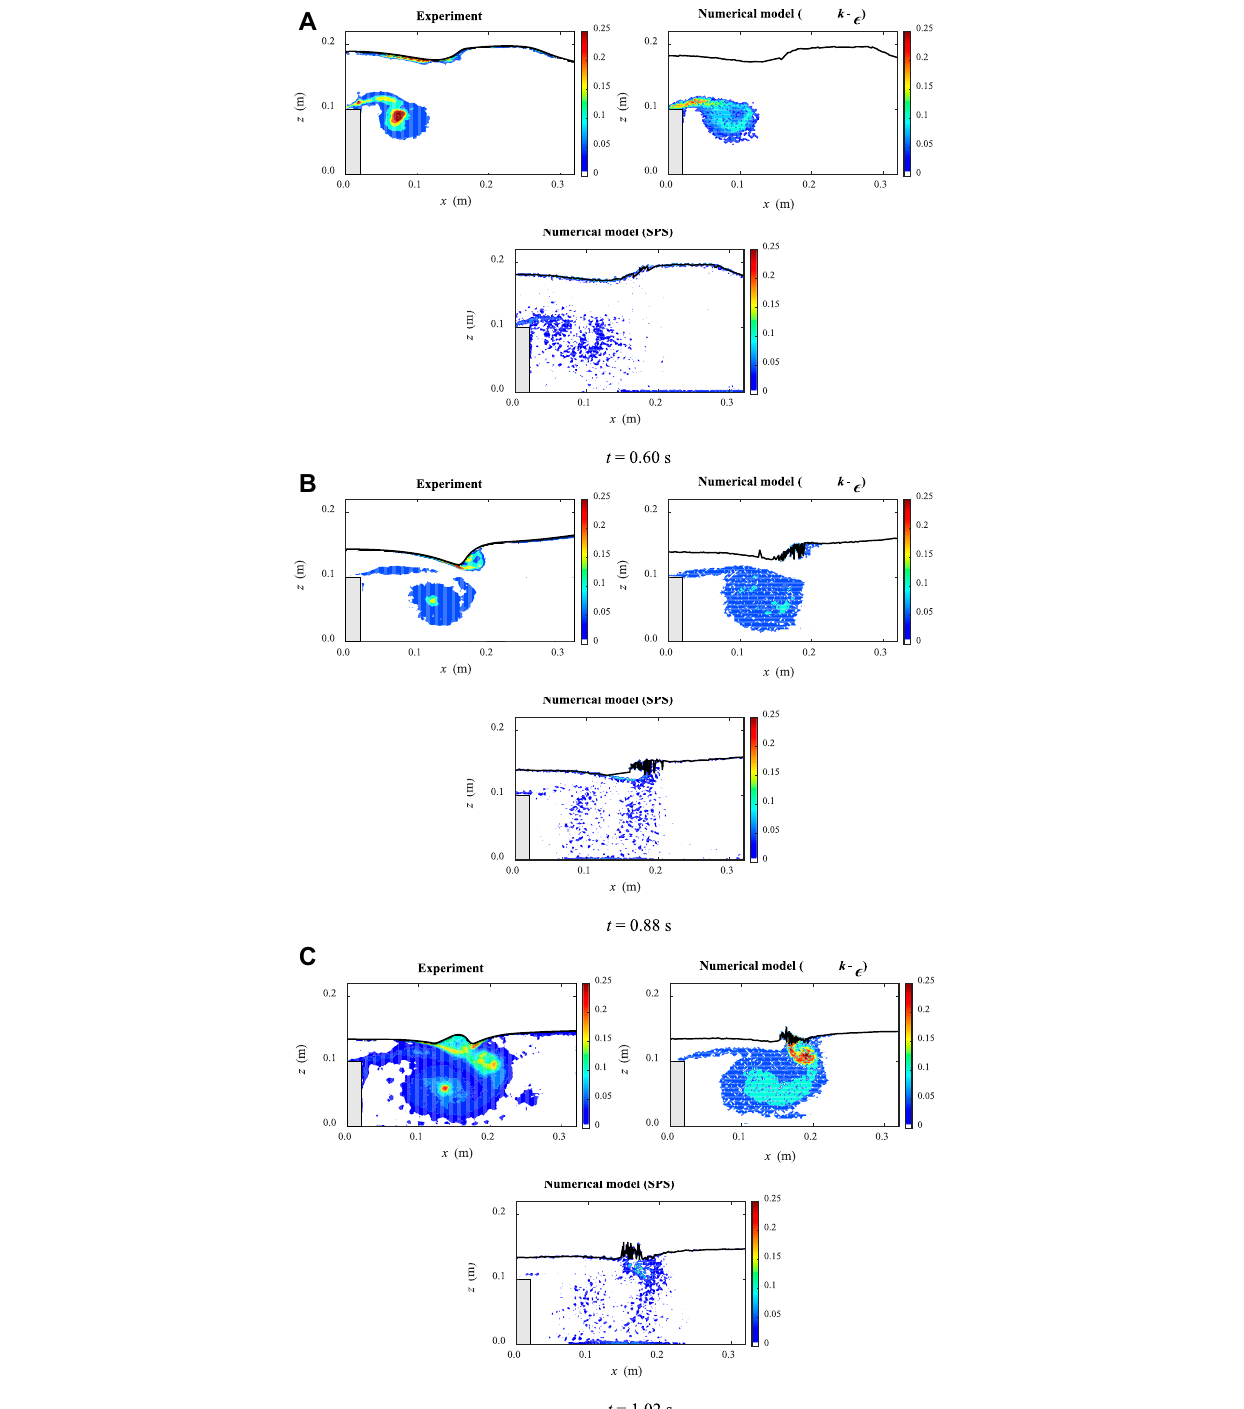
Frontiers in Environmental Science |